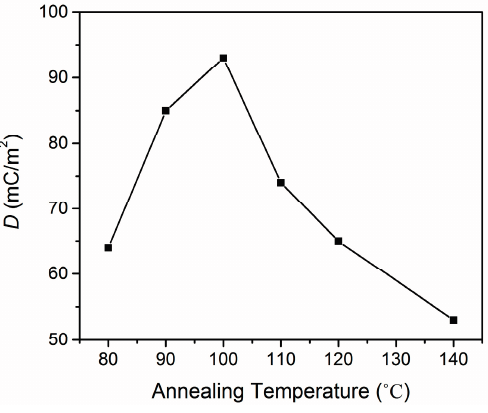
Figure 6. Dependence of remnant polarization, P r , as a function of annealing